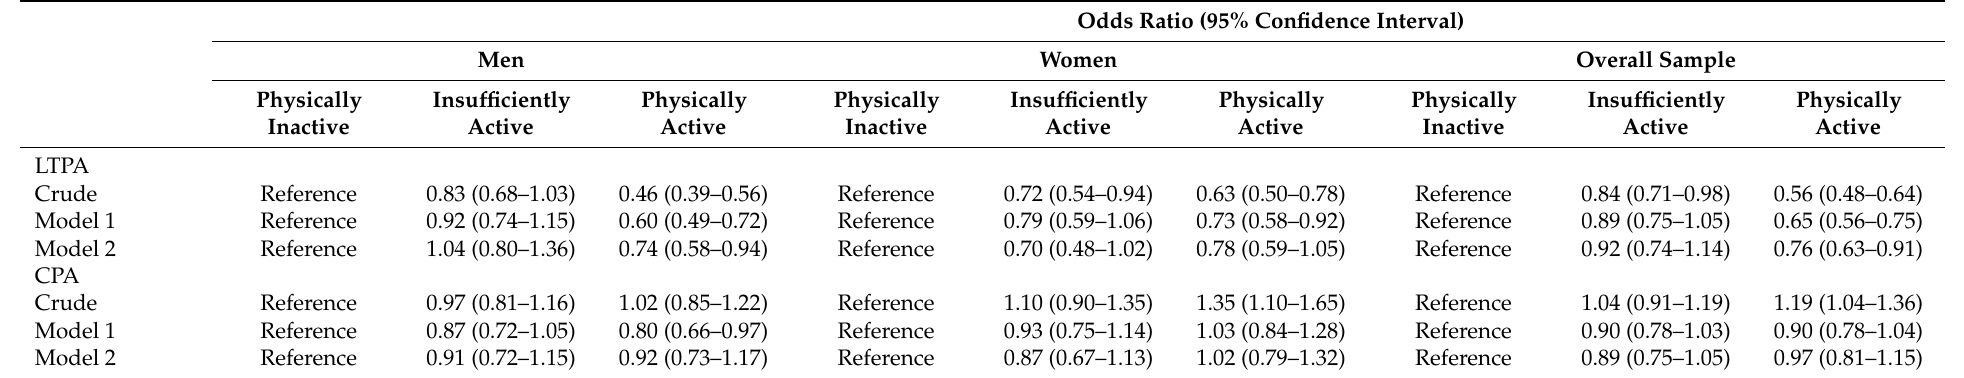
Table 3. Association of physical activity at leisure time and at commuting with diabetes in baseline participants of ELSA-Brasil study (n = 11,797). Odds Ratio (95% Confidence Interval)